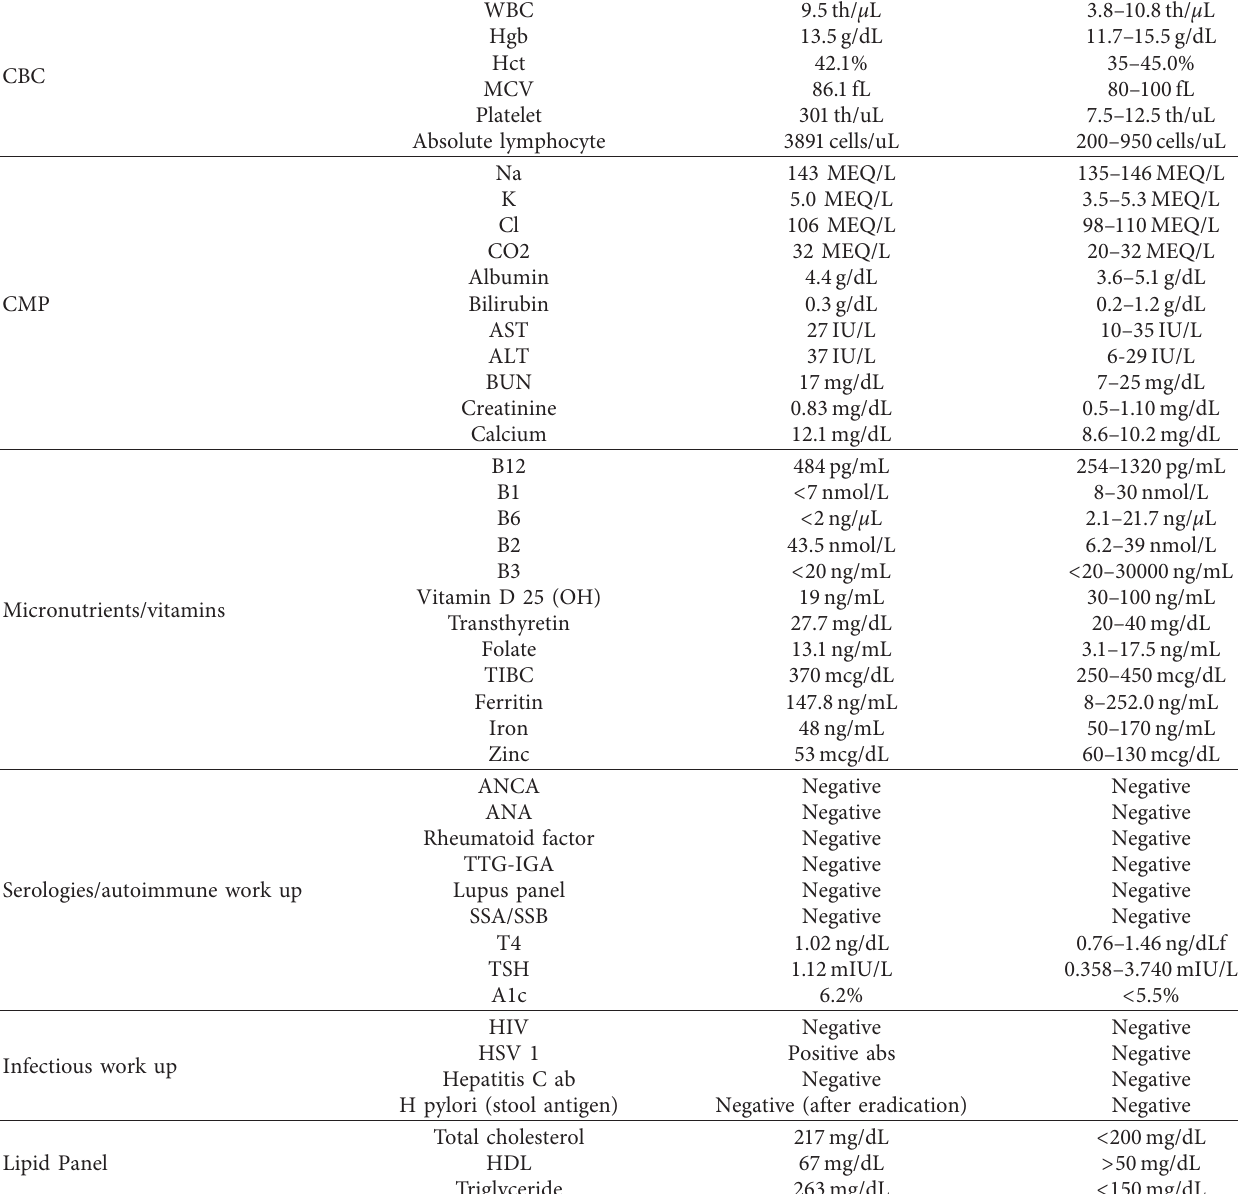
Table 1: Lab work in diagnosis of the etiology of the recurrent aphthous